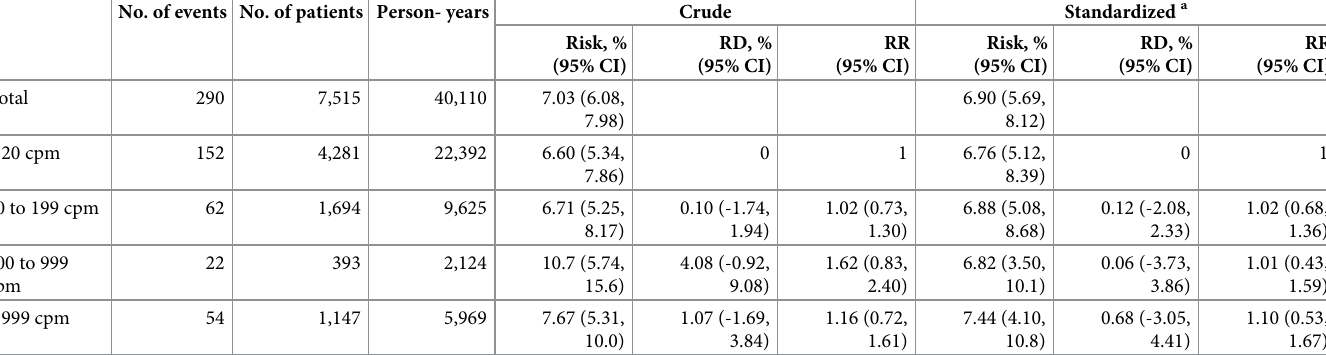
Table 3. Crude and standardized 10-year cumulative incidence, risk difference, and risk ratio estimates for first cancer diagnosis in 7,515 CNICS patients, averaged over 30 imputations. No. of events No. of patients Person- years